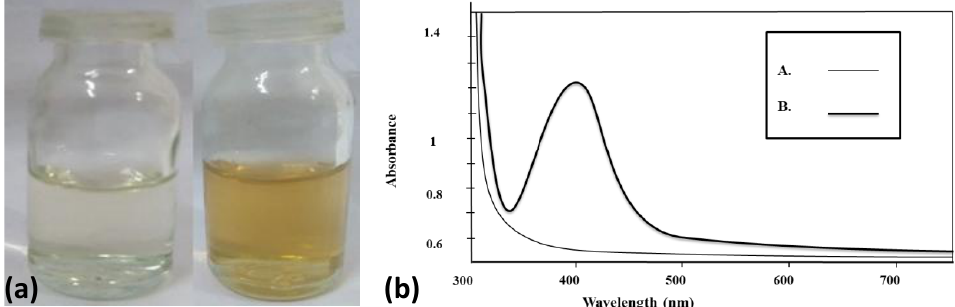
Figure 1. ( a ) Visual color change for the formation of AgNPs@AA ( b ) UV–Vis spectra of solution of adipic acid (A) and AgNPs@AA (B).